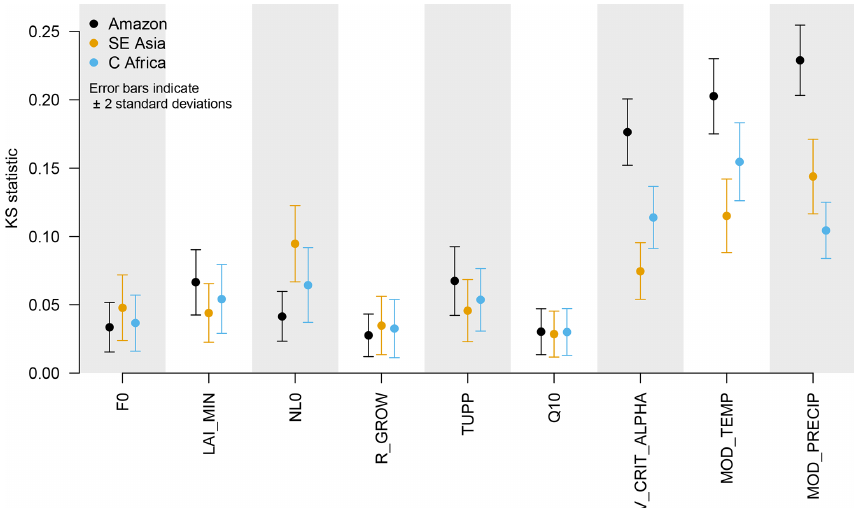
Figure 15. Monte Carlo filtering estimate of the sensitivity of model output to inputs, using 5000 emulated members. Error bars represent ± 2 standard deviations of uncertainty in the statistic, calculated by repeating the calculation 1000